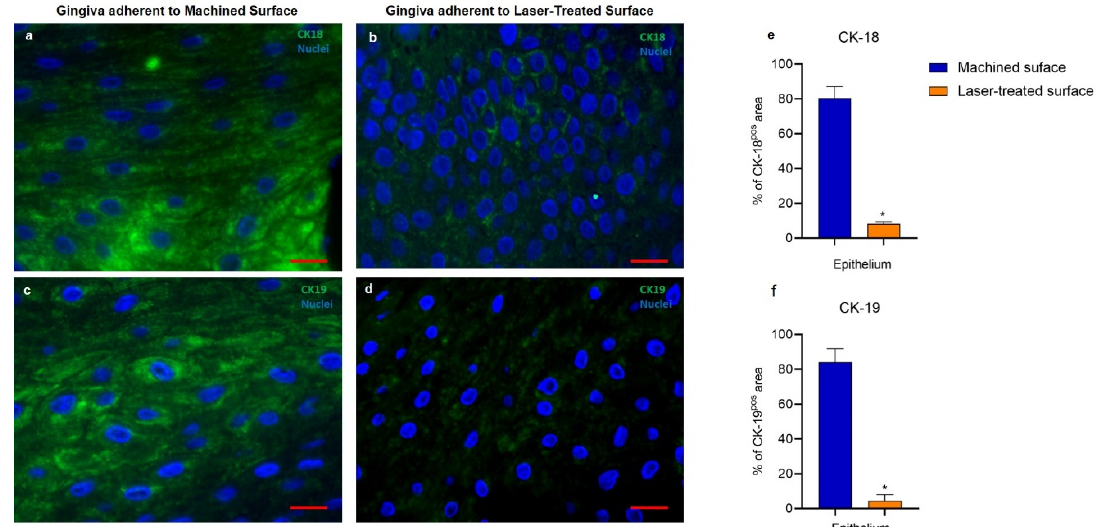
Figure 5. Immunofluorescence against CK-18 (green) ( a and b ) or CK-19 (green) ( c and d ) of the region of the gingiva adherent to the machined ( a , c ) or laser-treated ( b , d ) surface. Nuclei are counterstained with DAPI. Images are representative of 15 di ff erent experiments. Scale bar: 10 µ m. Bar graphs show the percentage of CK-18 ( e ) and CK-19 ( f ) immunostaining positive areas in the epithelial layers. Values are expressed as mean ± SD of five determinations in randomly chosen sections for each specimen. * indicates values statistically di ff erent ( p < 0.001) between the region of the gingiva adherent to the laser-treated- or to machined surfaces, as indicated.